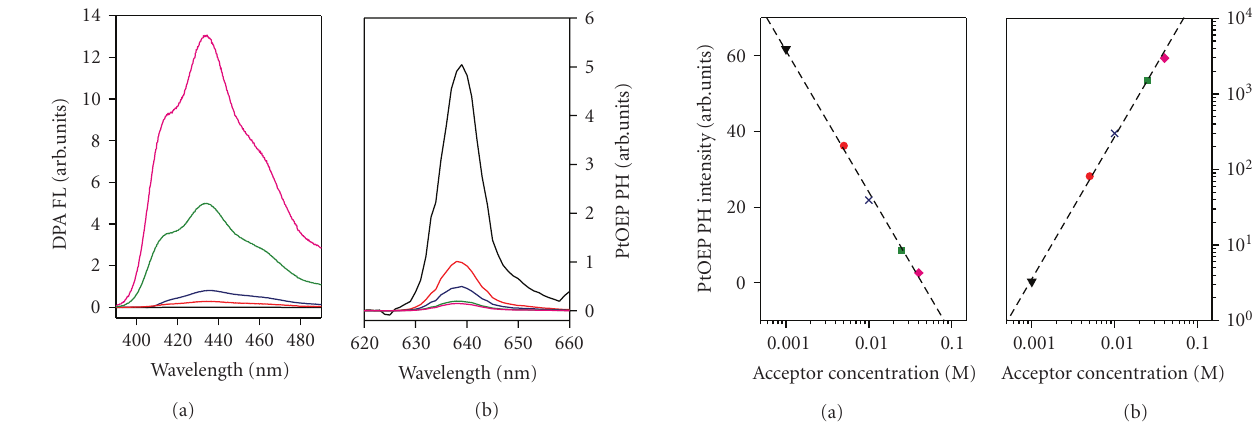
Figure 4: (a) PtOEP PH intensity at di ff erent acceptor concentra- tion. Dashed line is the fit with a linear function. (b) Corresponding DPA FL intensity. Dashed line is the fit with a linear function with m = 1 .